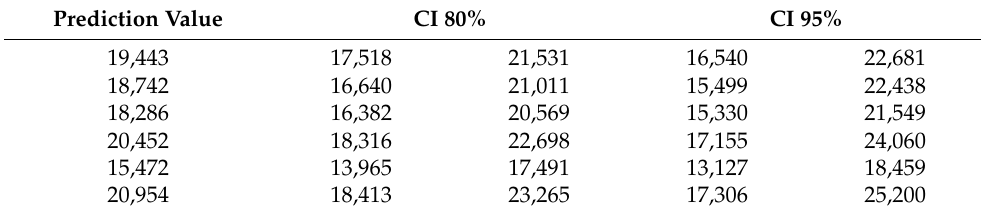
Figure 13. Correlogram of the residuals of the ARIMA model (25, 0, 0) (13, 0, 0) 1 (own elaboration). The model presents 25 correlation coefficients and a mean for the calculations. The greater complexity of the model compensates for the lower errors in the model and the Gaussian white noise in the residuals. Table 5 shows the predictions of the values (13) and the confidence intervals (CI) for 80% and 95% of the predictions. Table 5. Prediction extracts and their confidence intervals at 80% and 95%.